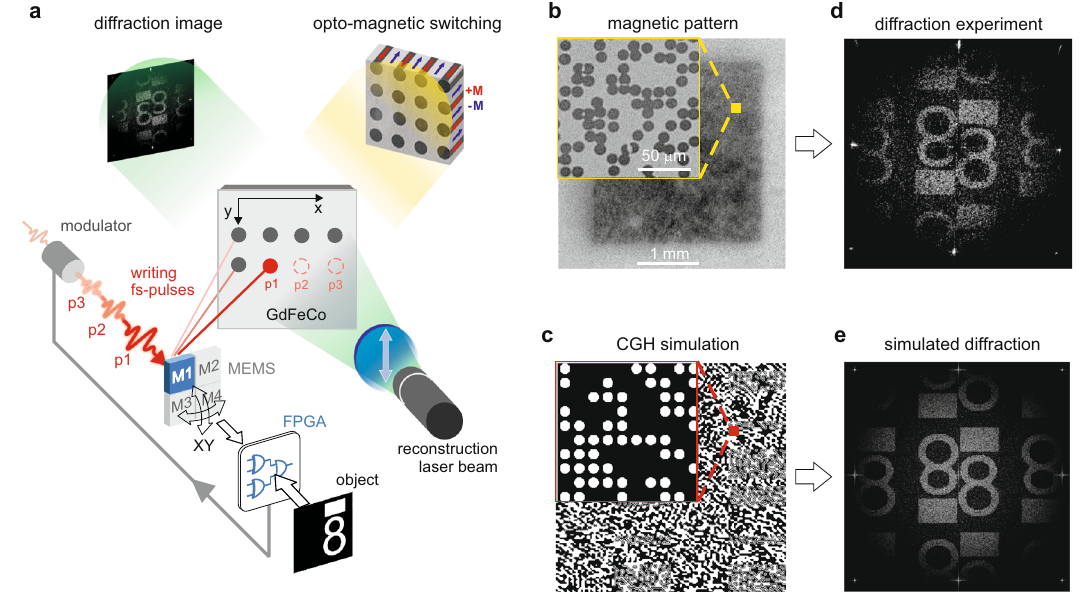
Fig. 1 | Serial writing of a CGH in an opto-magnetic medium. a Point-by-point optical switching of magnetic spots in GdFeCo sample with subsequent pulses p 1- p 3 from a femtosecond laser with a fl uenceof <20mJcm − 2 , re fl ected by a scanning MEMS mirror (M1), running free along raster-like or resonant (Lissajou) paths. M1 reports its current angles to the FPGA unit, which computes on-the- fl y the binary triggering signal for the intensity modulator of the femtosecond laser beam; the FPGA unit is fed with cloud-point representation of the input object, constraint to FPGA chip; geometrical imaging of the sample with a white polarized light using magneto-optical Faraday geometry; far- fi eld diffraction image observed on a